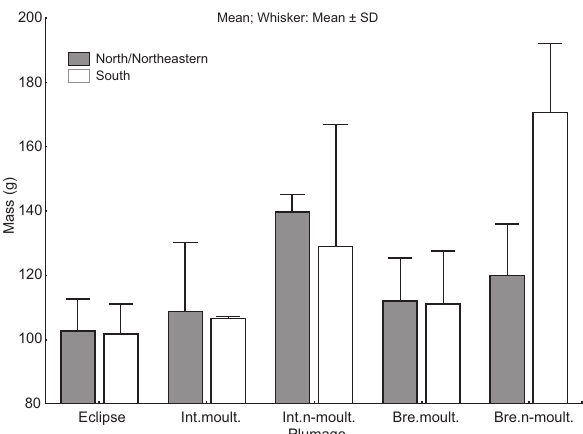
Figure 4. Correlation between the body masses of individuals of A. interpres over time in April and